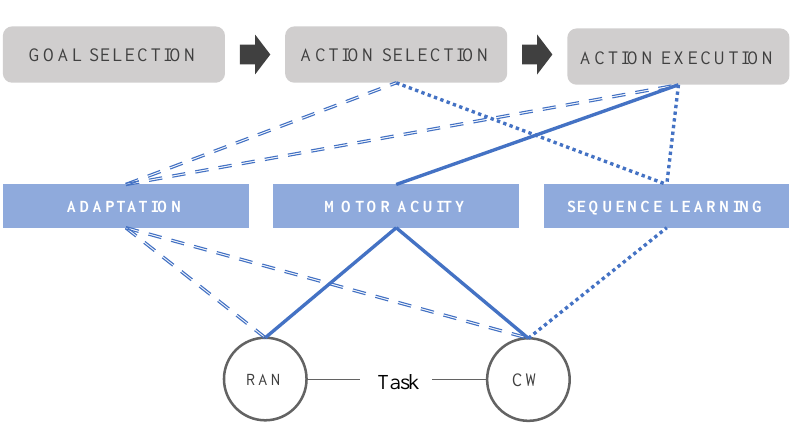
Figure 6. Framework for the proposed motor tasks (bottom layer) and their relationship with their respective motor learning paradigm (middle layer) and components (top